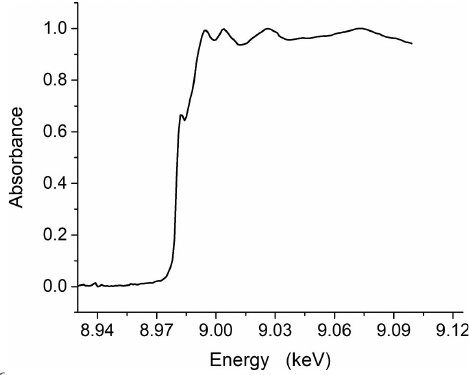
Figure 6 X-ray absorption fine-structure spectrum at the Cu edge.